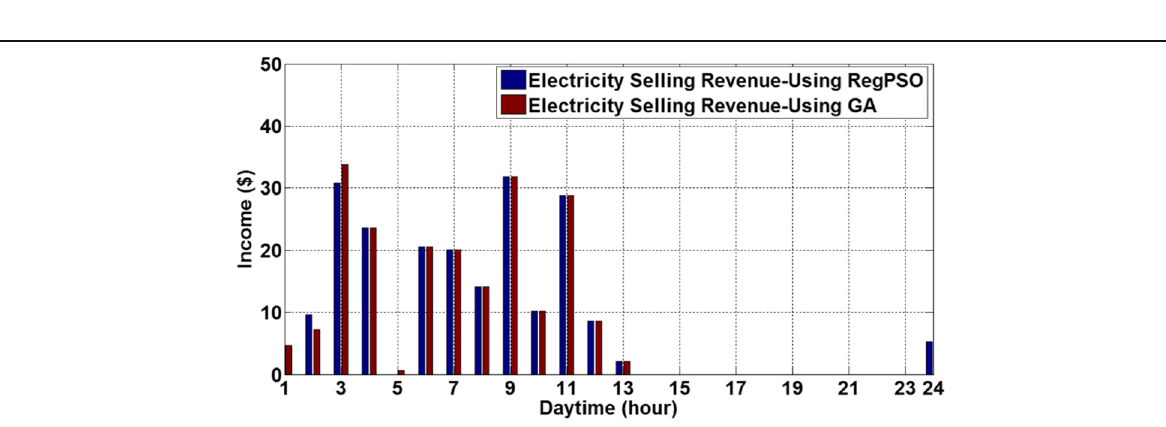
Fig. 18 Hourly comparison of energy selling revenue in non-isolated mode of operation